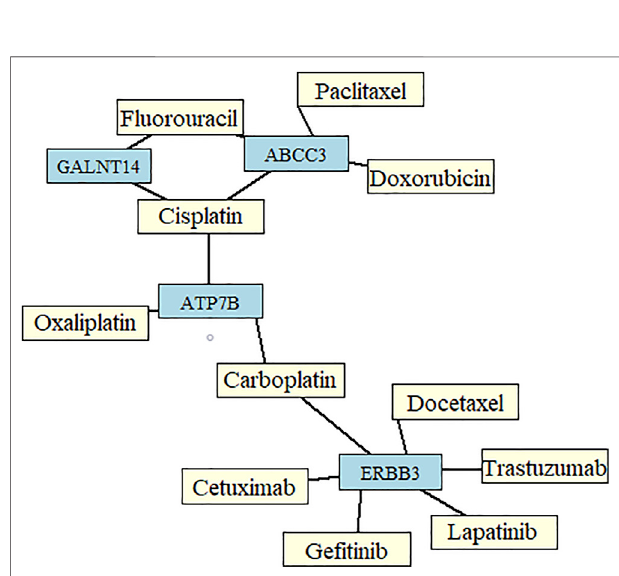
Table S2 . Top 10 over/under-expressed genes in SCC vs . AC and